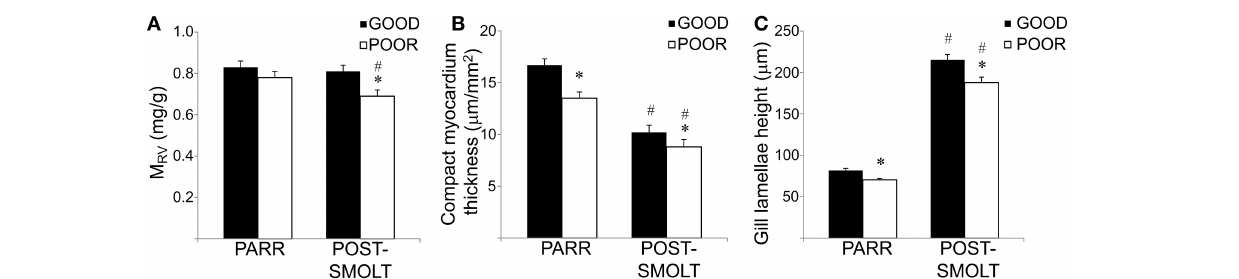
FIGURE 1 | Comparison of cardiac and gill morphometrics between swimming groups. (A ) Relative ventricle mass (M RV ); which is ventricle mass inmg divided by mass of fish in grams, (B) relative thickness of the compact layer in ventricle which is calculated as thickness/ventricle cross-section area